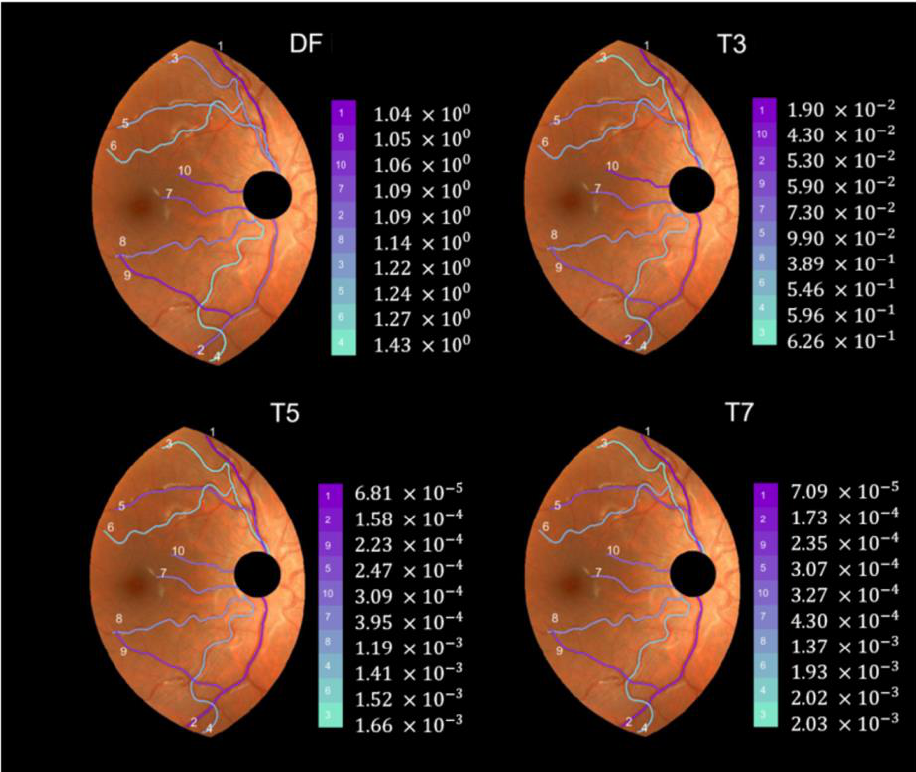
Figure 7. Individual tortuosity values (DF, T3, T5, and T7 indices) for the 10 selected vessels in DR2-ROI (D-retinography of subject 2′ s right eye).